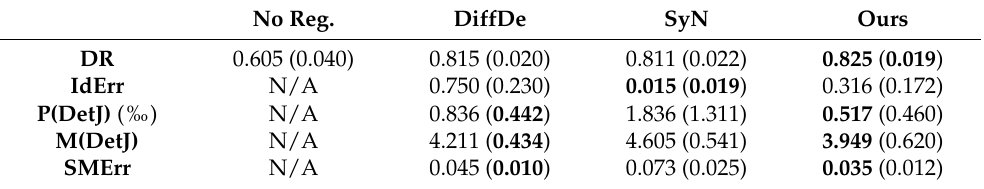
Table 3. The quantitative results in Section 3.4 are shown. The results represent the mean values and corresponding standard deviations with 90 registrations. The first row lists the methods, i.e., no registration (No Reg.), DiffDe , SyN , and Ours . The second to sixth rows represents the results of the DR , IdErr , P(DetJ) , M(DetJ) , and SMErr , respectively. The bolded numbers are the best results among different methods. No Reg. DiffDe SyN Ours DR 0.605 (0.040) 0.815